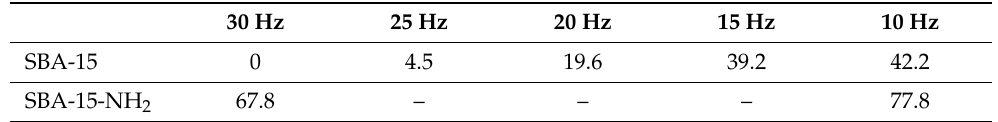
Table 1. Degree of crystallinity (%) of IBP confined in unmodified (SBA-15) and modified (SBA-15-NH 2 ) carriers for various milling